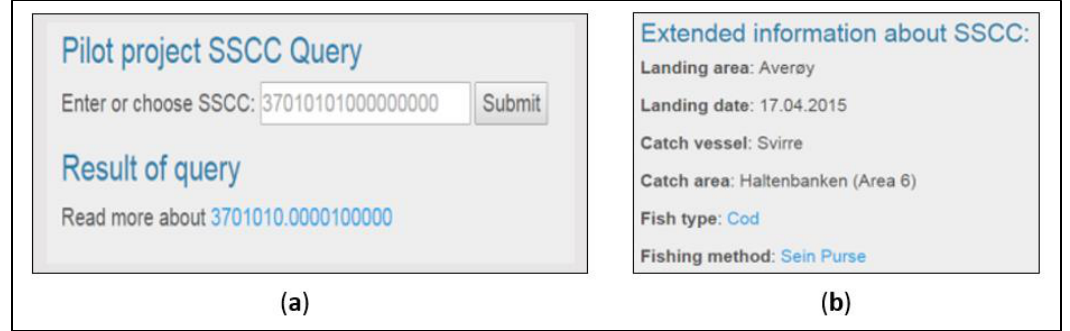
Figure 5. Demonstrator GUI for ( a ) entering SSCC codes and ( b ) the information retrieved.